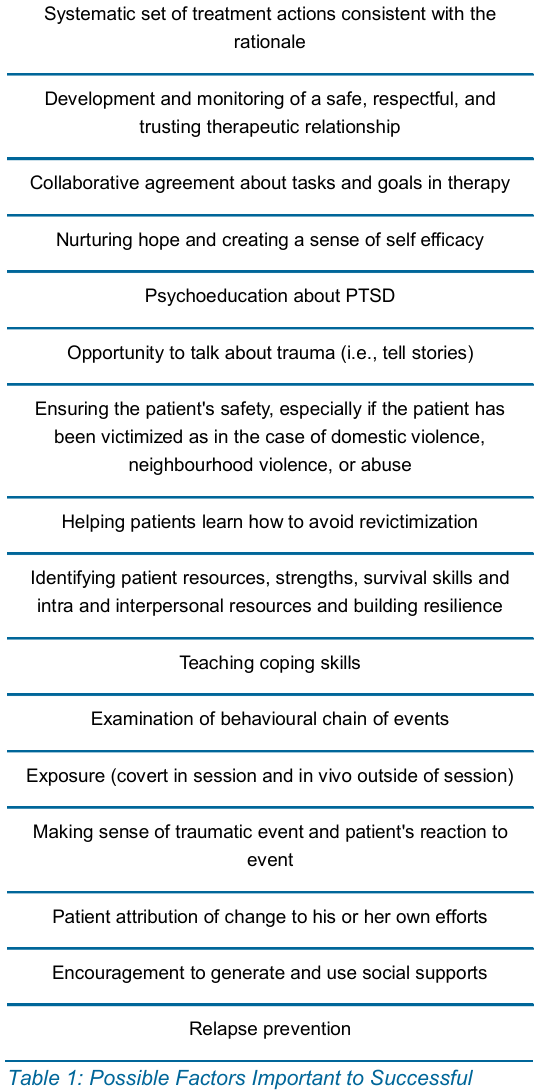
Table 1: Possible Factors Important to Successful Treatments of PTSD (Wampold et al, 2010, p.931, reproduced with